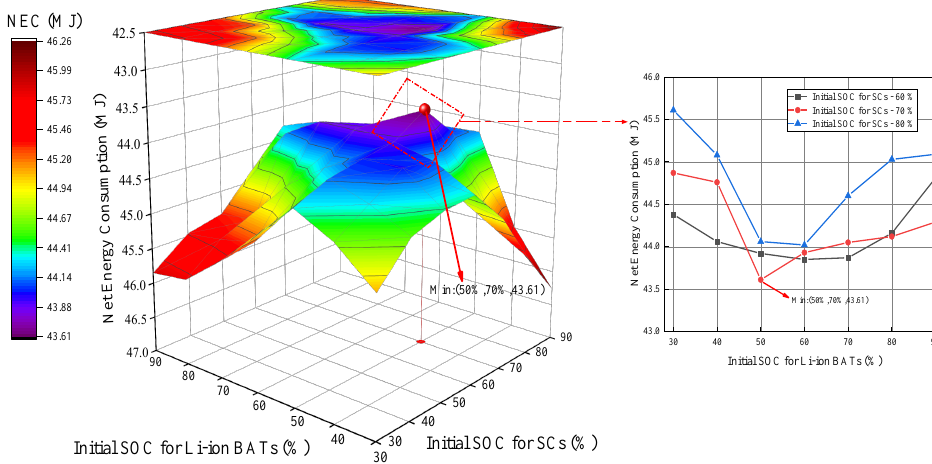
Figure 13. The NEC for different initial SOC of on-board